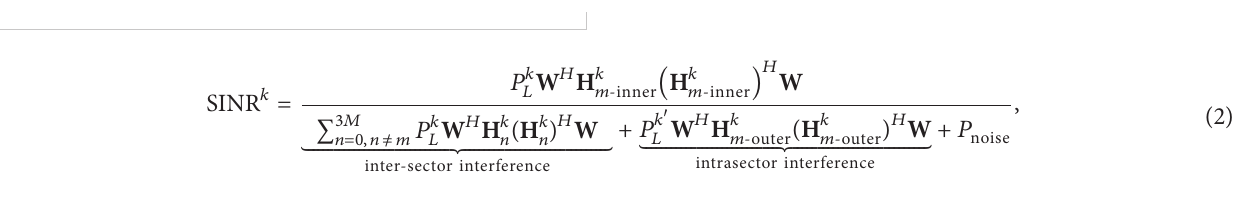
Figure 2: Limitation of vertical sectorization. Figure 3: Intrasector interference brought by vertical